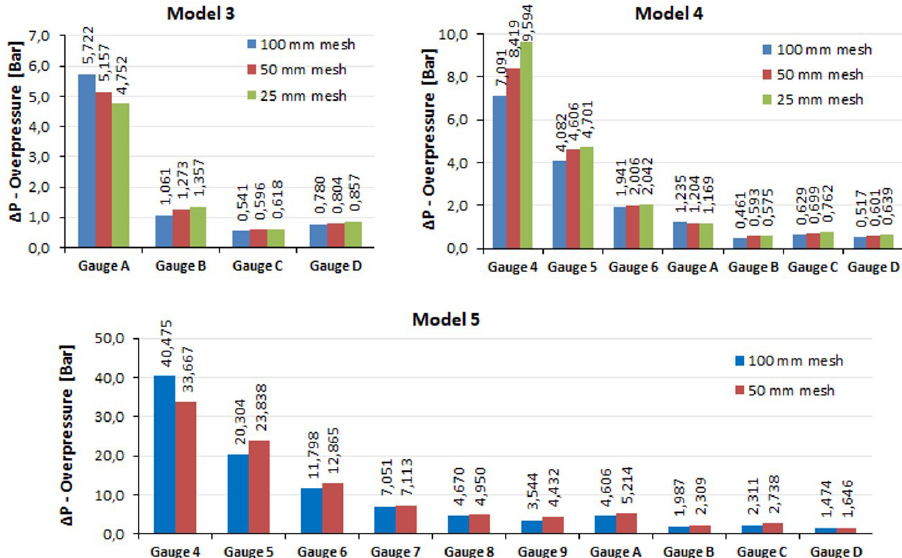
Figure 14. Overpressure peaks in gauges of models 3, 4, and 5 (explosions of aboveground tanks with volumes of 5,5 m 3 , 8,0 m 3 , and 120 m 3